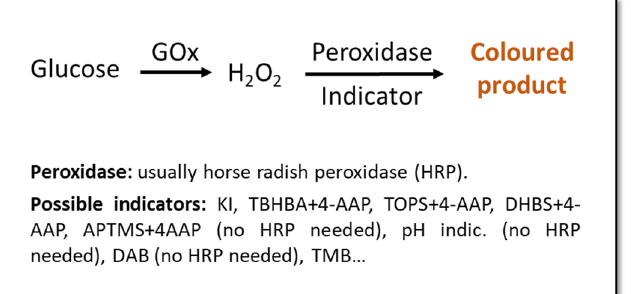
Figure 1. Schematic representation of classic enzymatic colorimetric methods for the detection of glucose. Indicators: potassium iodide (KI) [70–77], 2,4,6-tribromo-3-hydroxy benzoic acid (TBHBA) + 4-aminoantipyrine (4-AAP) [78,79], N-ethyl-N(3-sulfopropyl)-3-methyl-aniline sodium salt (TOPS) + 4-AAP [80], 3,5-dichloro-2-hydroxybenzenesulfonic acid (DHBS) + 4-AAP [81], 3-aminopropyltriethoxysilane (APTMS) + 4-AAP [82], pH indicator [83], 3,3 ′ -diaminobenzidine (DAB) [84], 3,3 (cid:48) ,5,5 (cid:48) -tetramethyl-benzidine (TMB) [81,85]. Table 2. Acetone [32] and glucose concentrations (mg/dL [33] and mM [32] units) in diverse relevant physiological fluids from patients with or without diabetes. The pH of the fluid [32] and the time required to diffuse blood from the capillaries to the tissues (time lag) [33] are also shown. Fluid Non-Diabetic Diabetic pH Time Lag